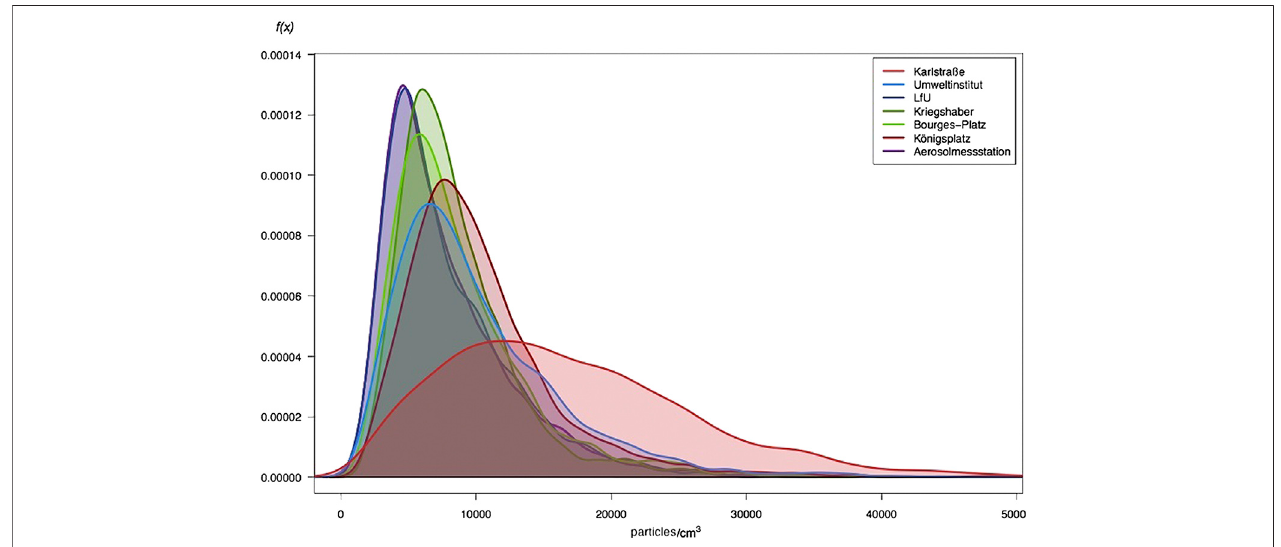
FIGURE 5 | Probability density functions of the UFP number concentrations differentiated according to measurement sites.